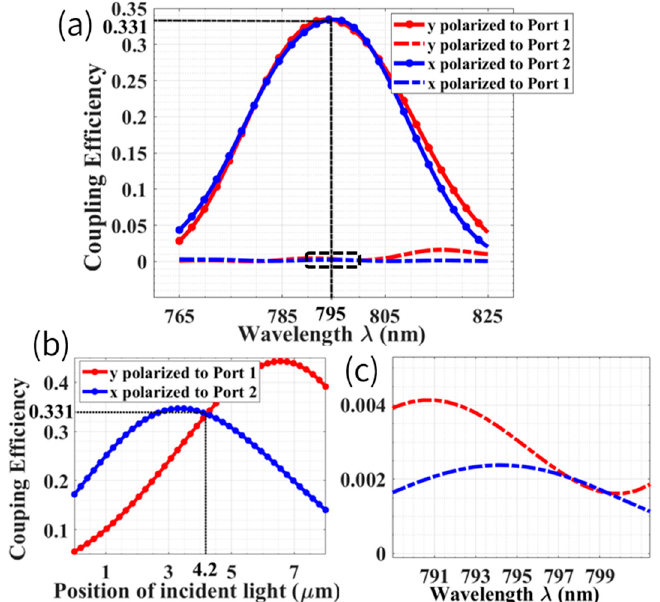
Figure 4. ( a ) Simulated coupling efficiency versus wavelength of incident light. ( b ) The dependence of coupling efficiency as a function of incident light position; zero at x -axis means left boundary of grating. ( c ) The enlarged view inside the dotted box in ( a ).